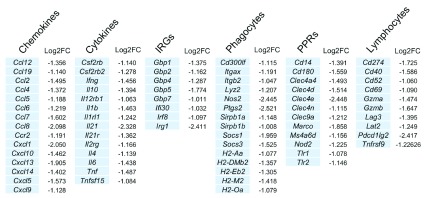
Immune genes down regulated following AmBisome
® treatment in the liver.74 immune-associated down regulated genes grouped according to functional category or main cellular localisation. Log2 fold change in expression is indicated. IRGs, interferon regulated genes, PPRs, pattern recognition receptors. Full list of up and down regulated genes at each time post treatment are found in
Extended data: Table S1.